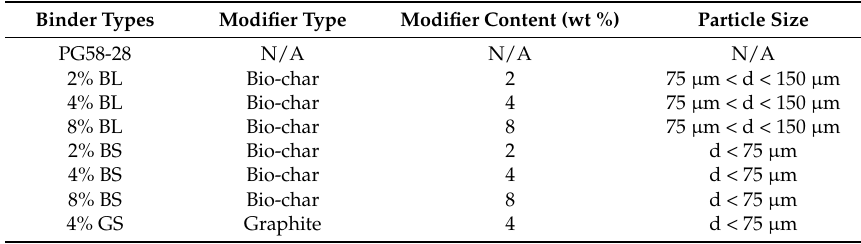
Table 2. Sample range